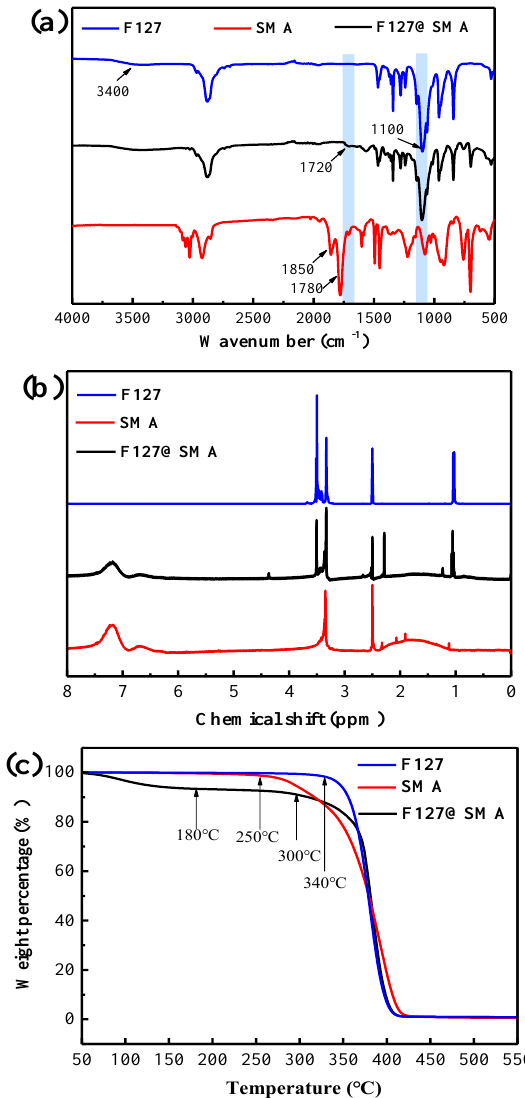
Figure 1. Characterization of the F127@SMA: ( a ) FT − IR, ( b ) 1 H NMR, and ( c ) TGA.